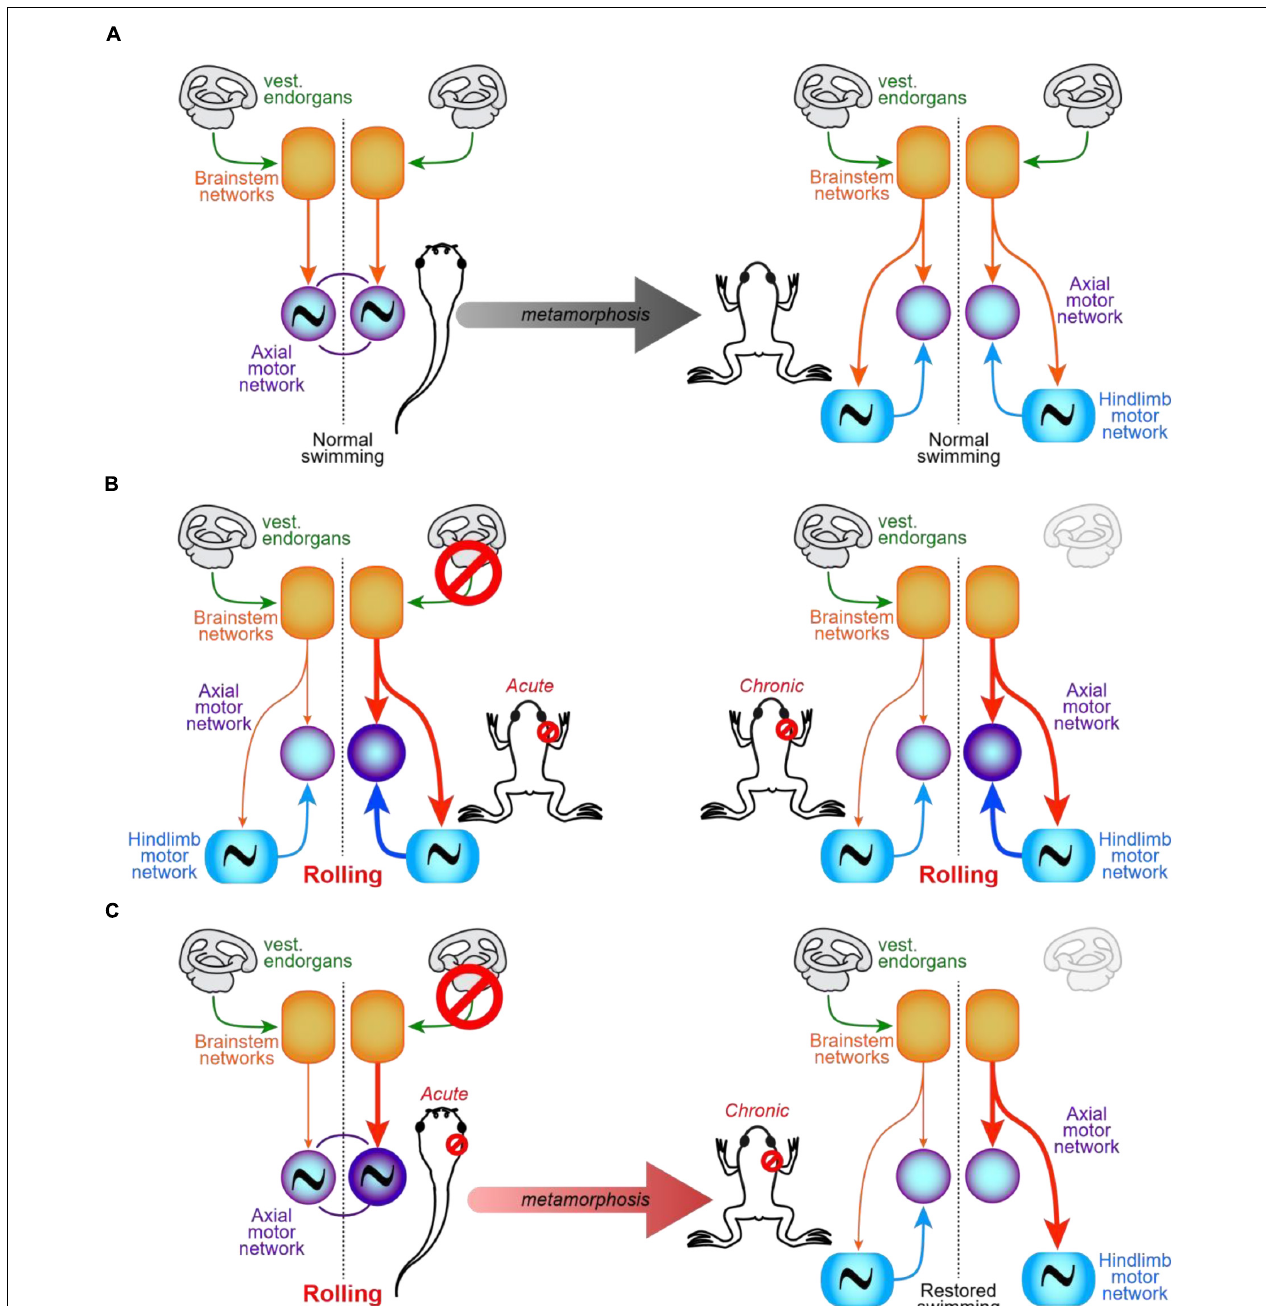
FIGURE 5 | Functional organization of the spinal posturo-locomotor network in the intact and vestibulo-lesioned Xenopus . (A) Schemes illustrating the symmetrical organization of the most basic brainstem/spinal cord sensory-motor network responsible for the control of locomotion and posture in intact pre-metamorphosis tadpole (left) and post-metamorphosis juvenile (right) Xenopus (adapted from Beyeler et al., 2008). (B) Acute (left) and chronic (time interval equivalent to metamorphosis duration; right) effects of a right-side UVD in the juvenile Xenopus . Note that vestibular endorgans/Scarpa ganglion removal generates a net ipsilesional over-excitation of the spinal network, which results in a permanently impaired locomotor behavior (i.e., rolling swimming toward the lesion side; adapted from Beyeler et al., 2013). (C) Acute UVD (left) triggers spinal imbalance and rolling behavior in tadpoles. In contrast, after the animals had metamorphosed (right) normal swimming is restored although bilateral descending commands remain imbalanced. Recovery is allowed by a symmetrical activation of the postural axial network resulting from the construction, during metamorphosis, of an asymmetrical propriospinal posturo-locomotor network (adapted from Beyeler et al., 2013). Thin lines, normal activation; thick lines, hyper-activation; vest.,